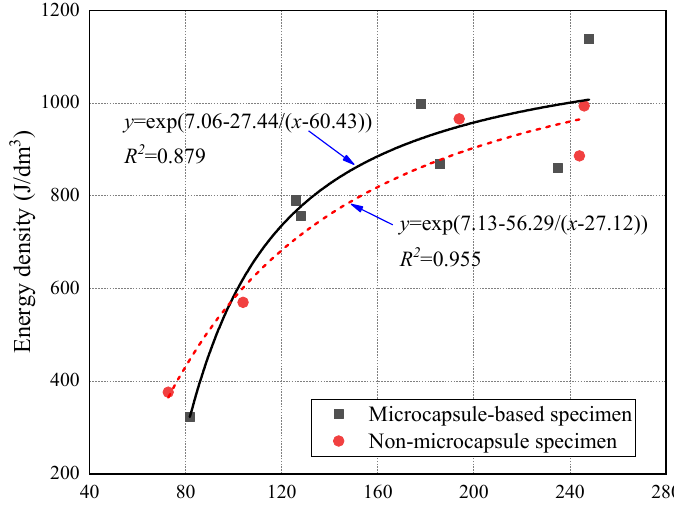
Figure 11. Energy density varied with incident energy.